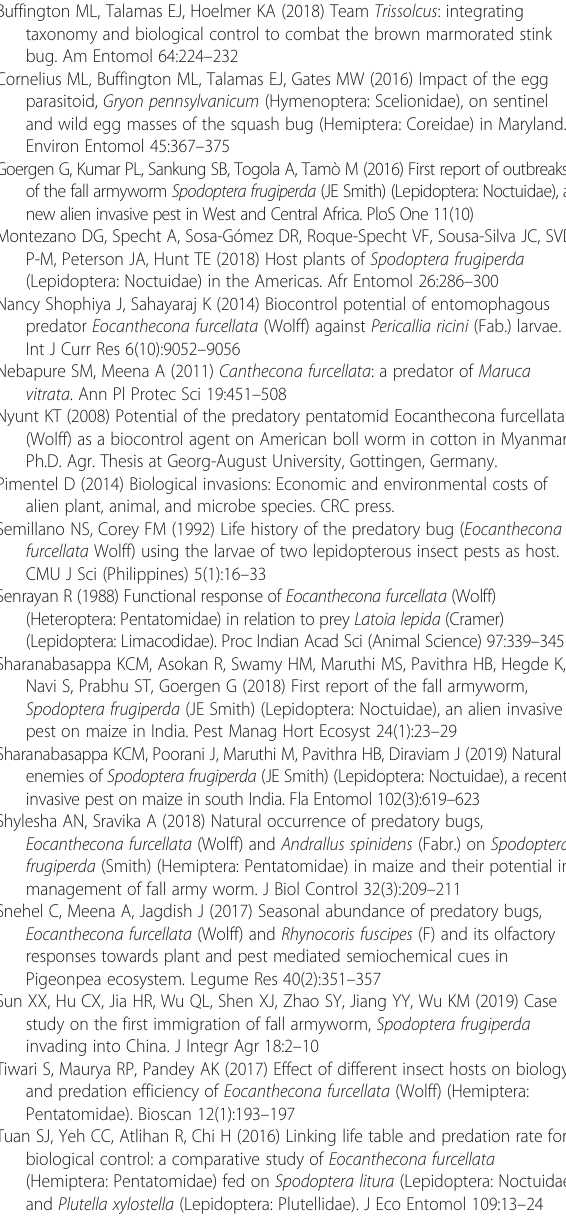
Fig.: Figure; NBAIR: National Bureau of Agricultural Insect Resources; UAS, GKVK: University of Agricultural Sciences, Gandhi Krishi Vigyana